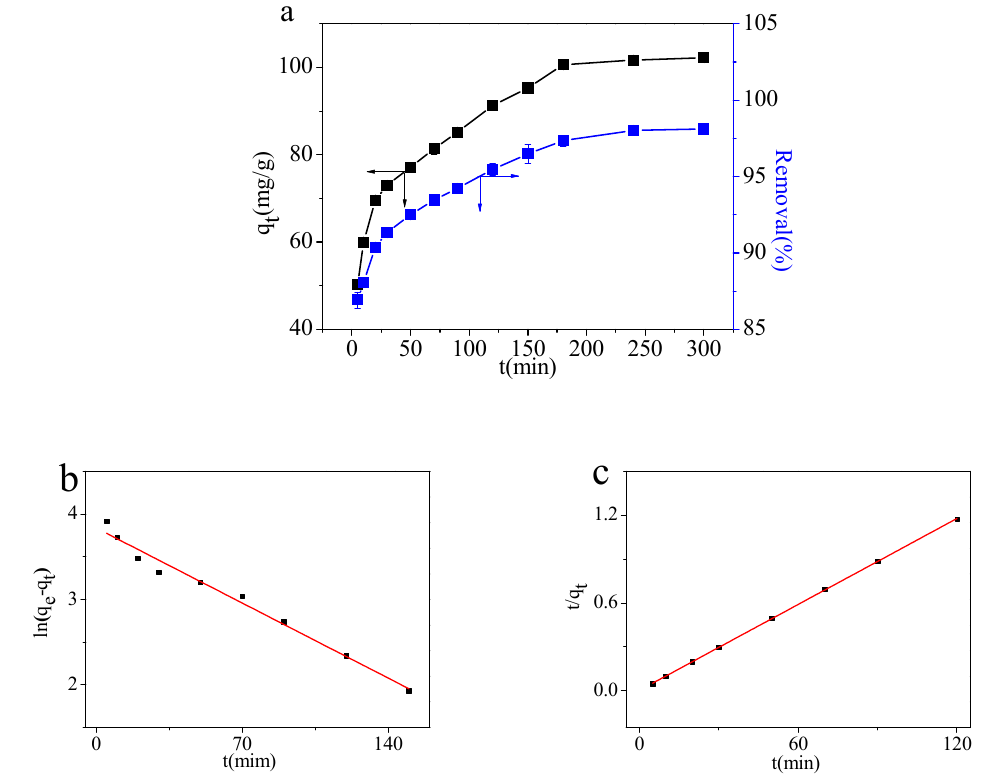
Figure 6. ( a ) Effect of contact time on Pb(II) adsorption capacity of MIL-125-CS. Data fitted to ( b ) pseudo-first-order and ( c ) pseudo-second-order kinetic models.